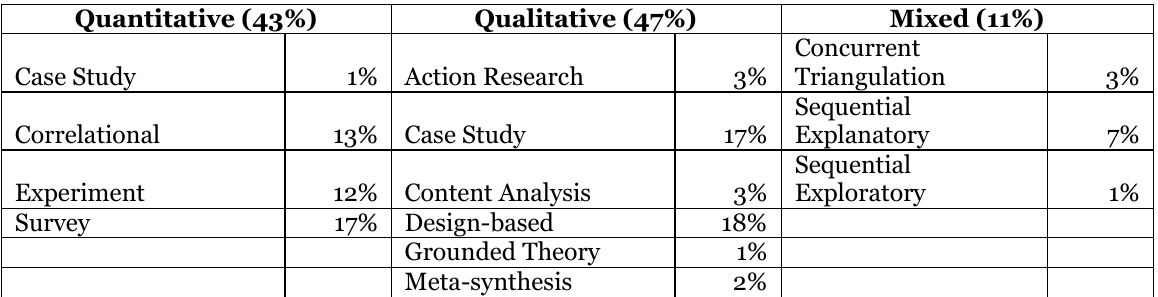
Distribution of Studies by Research Design Quantitative (43%) Qualitative (47%) Mixed (11%) Case